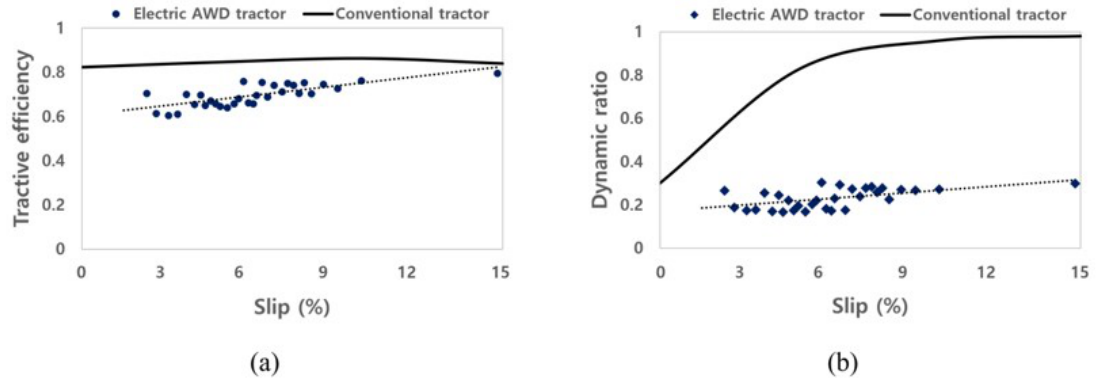
Figure 12. Analysis of traction performance as slip for the electric AWD tractor: ( a ) tractive efficiency, and ( b ) dynamic ratio.